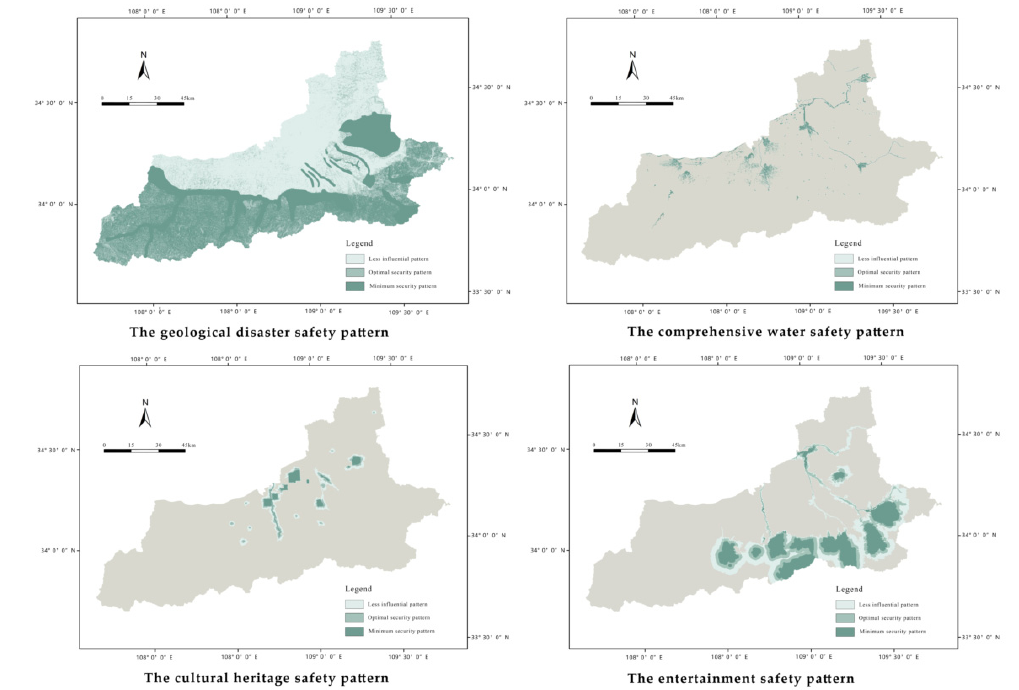
Figure 6. Single landscape security pattern.